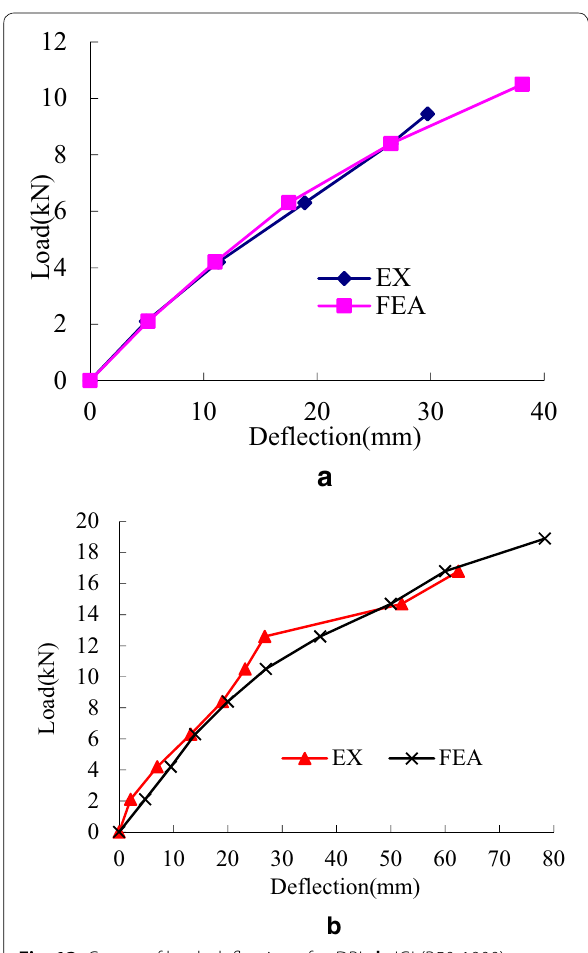
Fig. 12 FEA model of timber beam Fig. 13 Curves of load–deflection of: a DBL; b